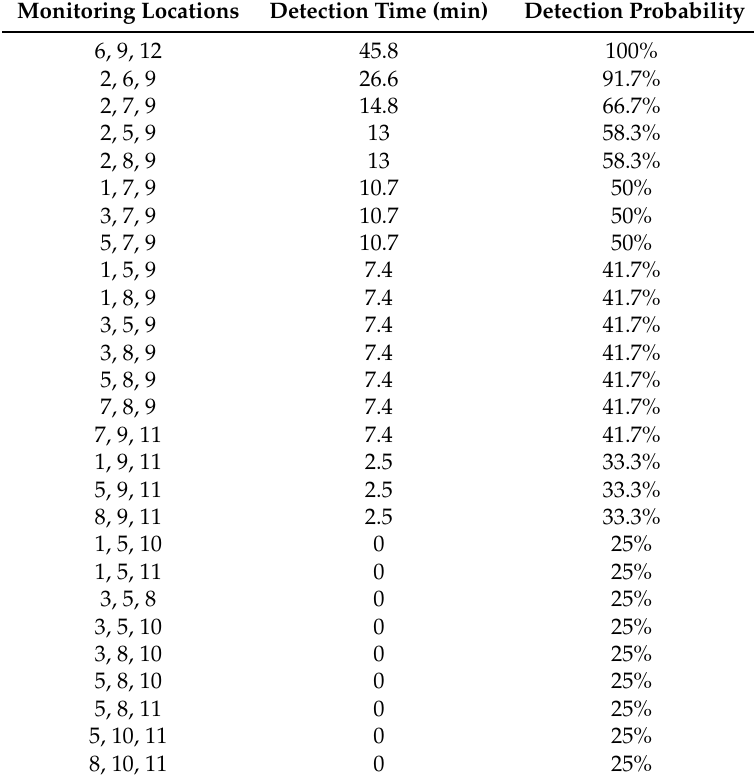
Table 5. Pollution detection time and pollution detection probability in Pareto frontier with a detection threshold of 0.01